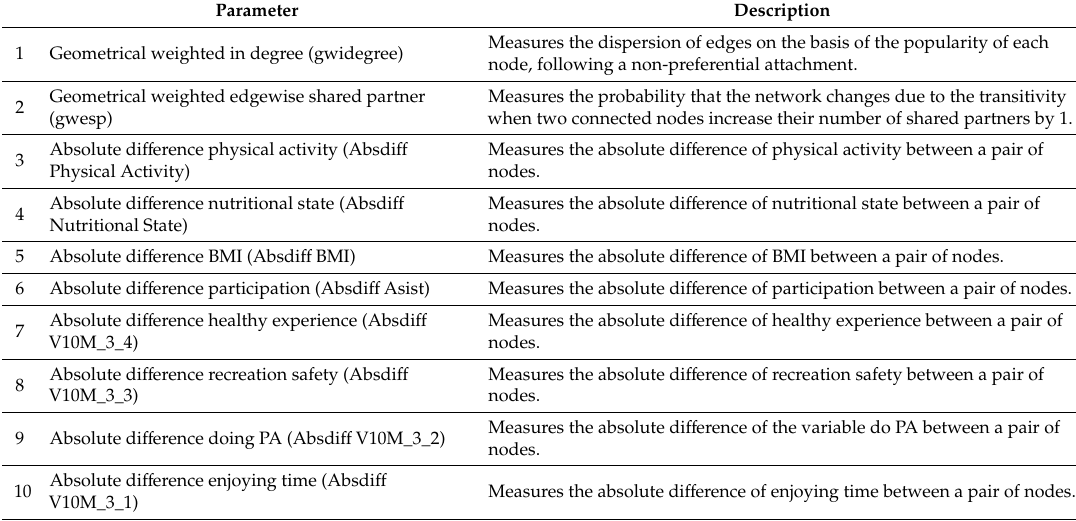
Table 2. Parameters used in the separable temporal exponential random graph models (STERGMs) to measure the formation and dissolution of friendship